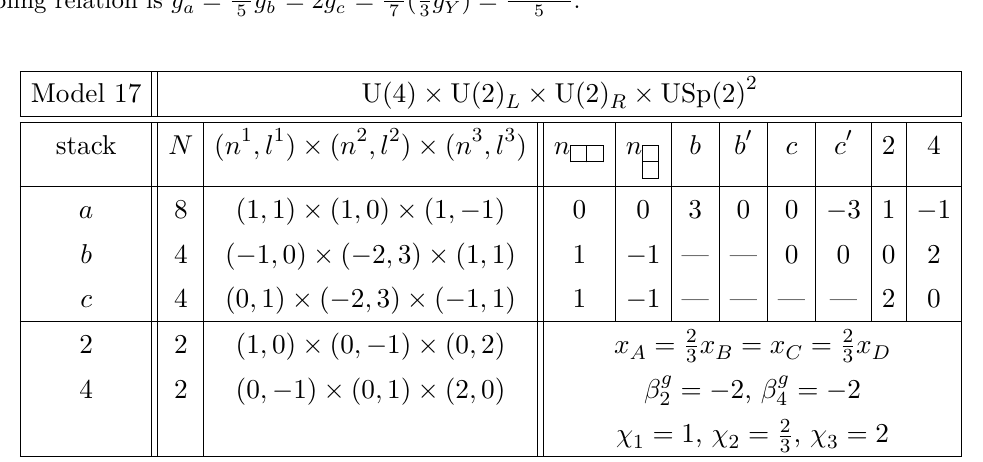
Table 23 . D6-brane configurations and intersection numbers of Model 16, and its MSSM gauge coupling relation is g 2